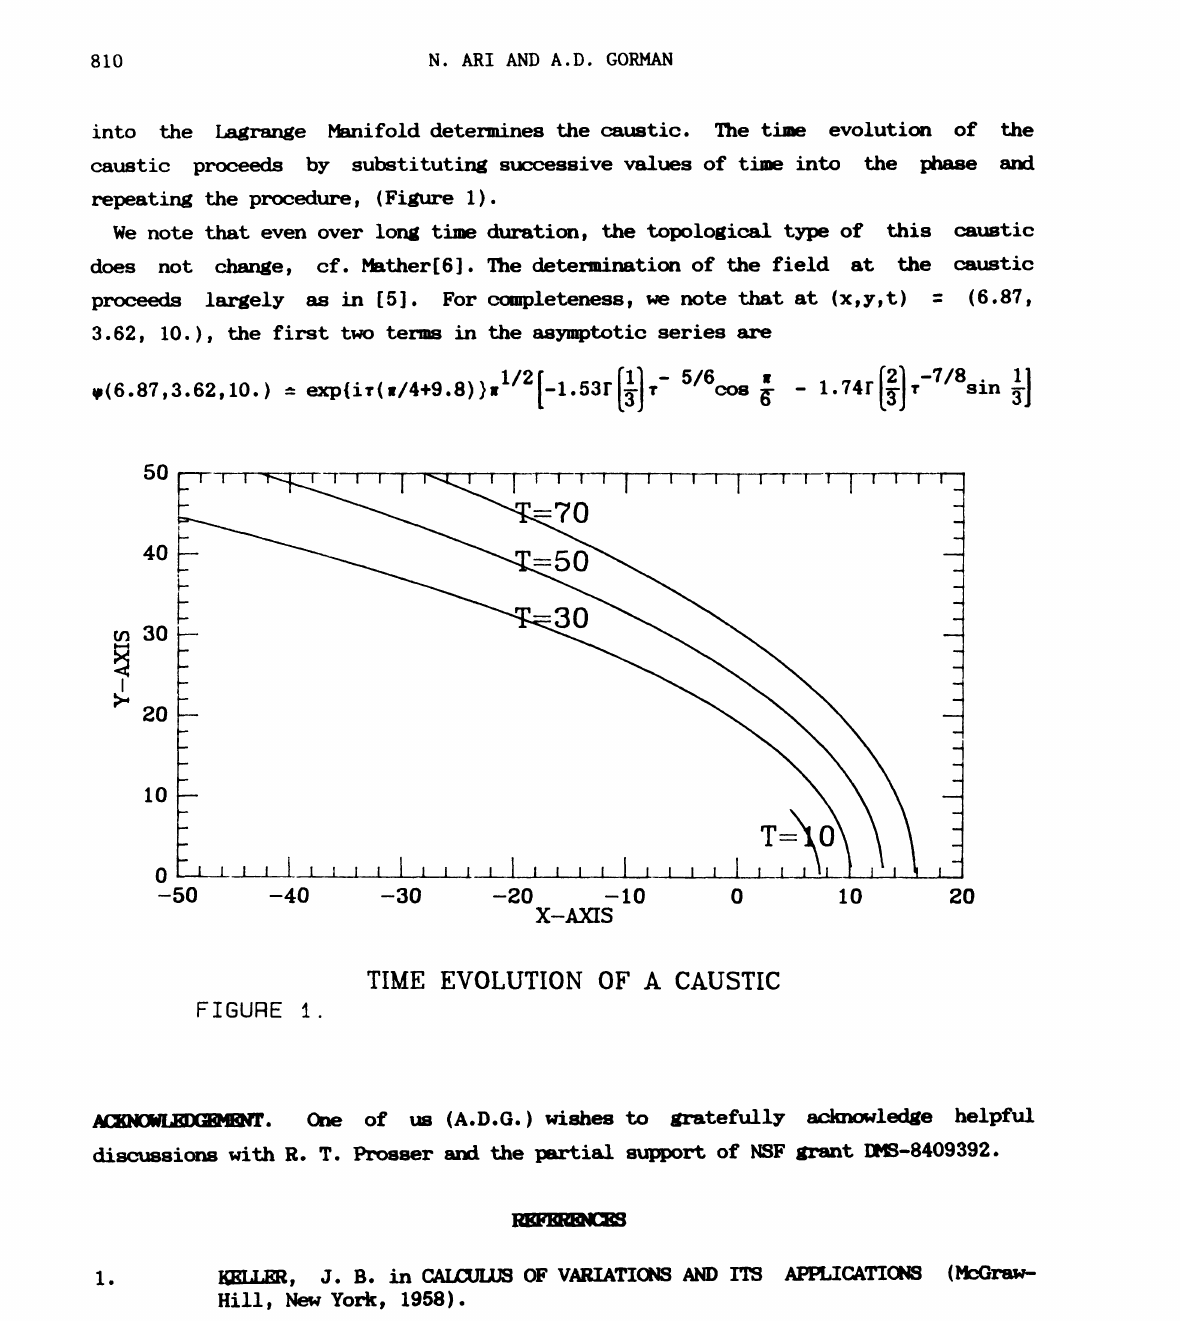
TIME EVOLUTION OF A FIGURE I.